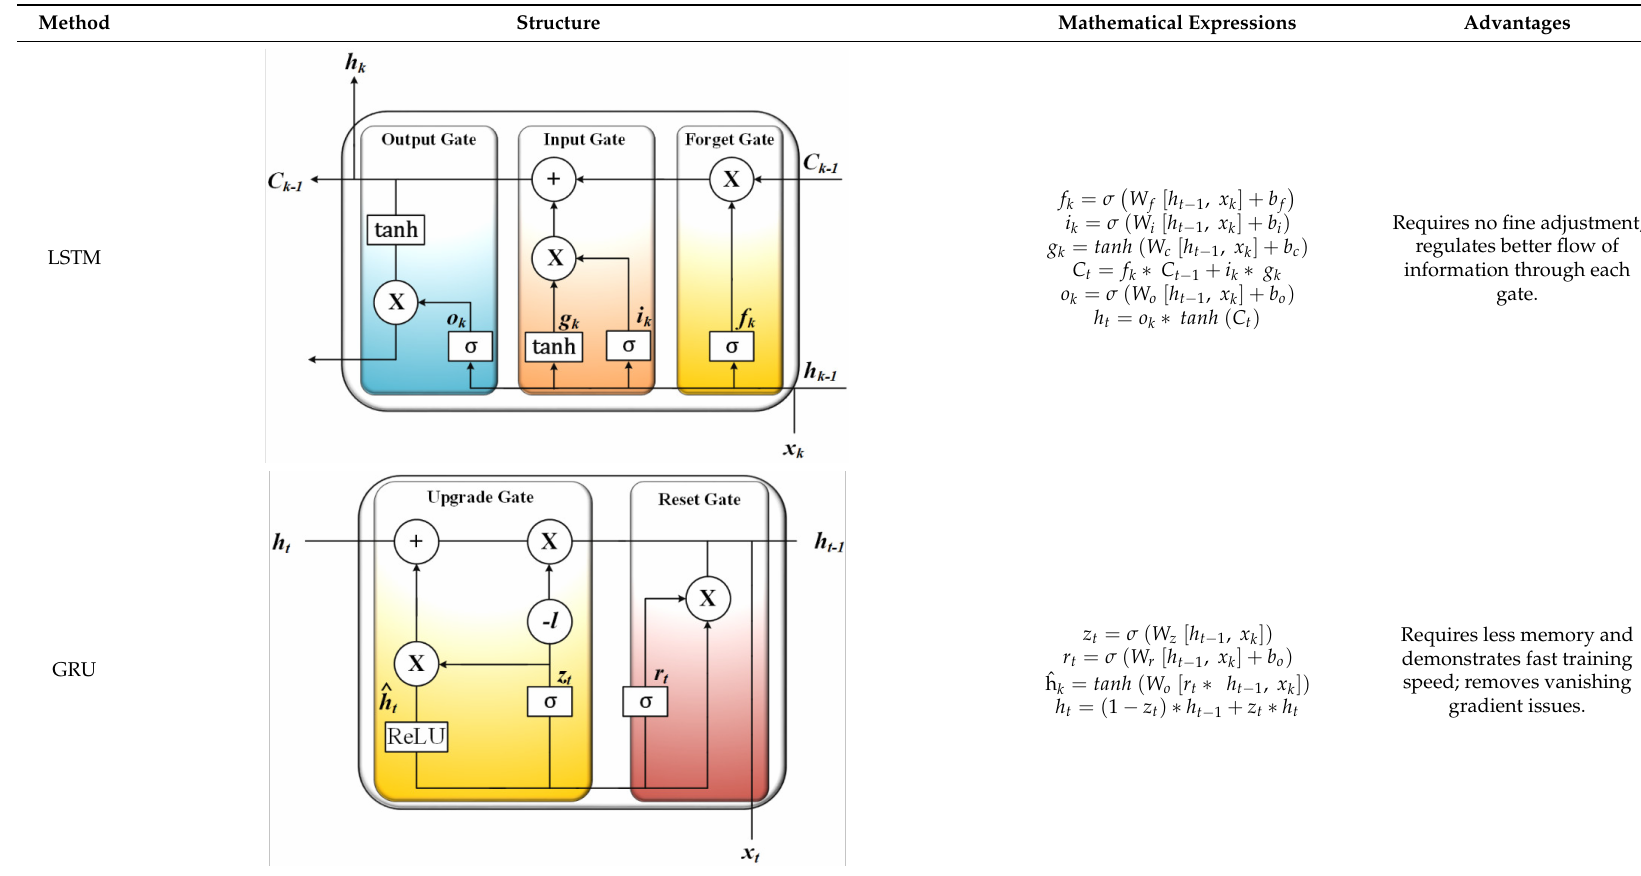
Table 2. Structure, mathematical expressions, advantages, and disadvantages of DL